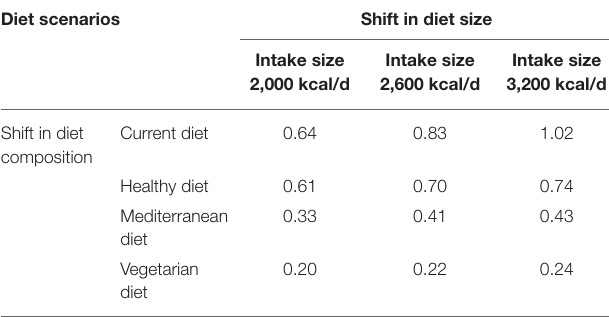
TABLE 2 | Per capita land area (ha) required to support the current diet and US Dietary Guideline recommended “Healthy,” “Mediterranean,” and “Vegetarian” diets at three levels of caloric intake.